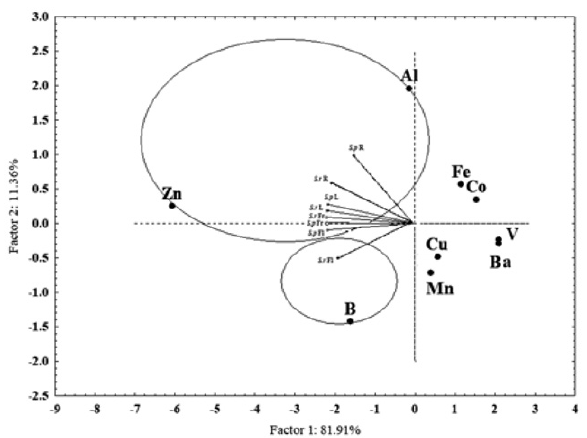
Figure 4. PCA diagram of variables of the macroelements content (Na, Mg, Ca, and K) in the leaf, flower, fruit, and root of plant spe- cies S. rigidum and S. pallasii